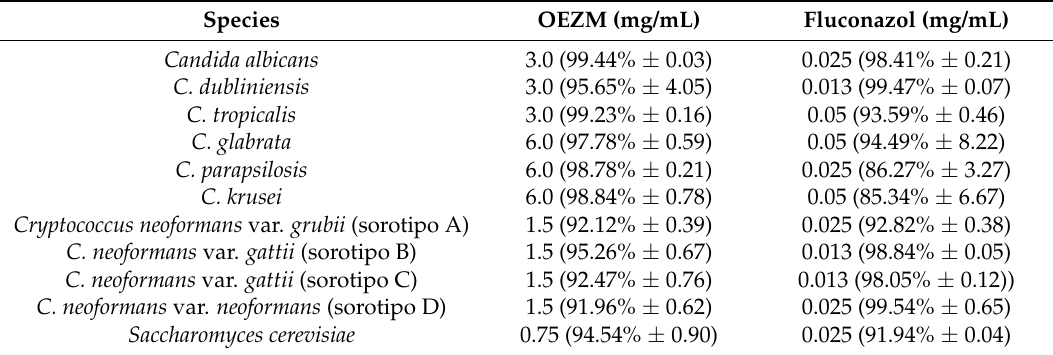
Table 4. Minimum inhibitory concentrations (MICs) for Z. monogynum essential oil and positive control (fluconazole) both expressed in mg/mL. Numbers in parenthesis represent the average percentage inhibition for each MIC followed by the standard